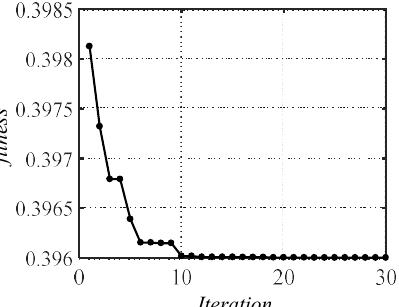
Figure 6. The change of fitness function value during optimization.